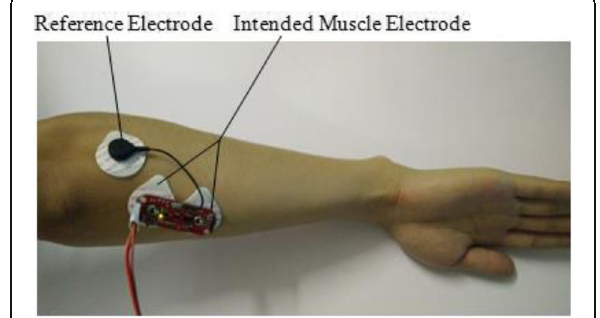
Fig. 3 Electrode ’ s placement